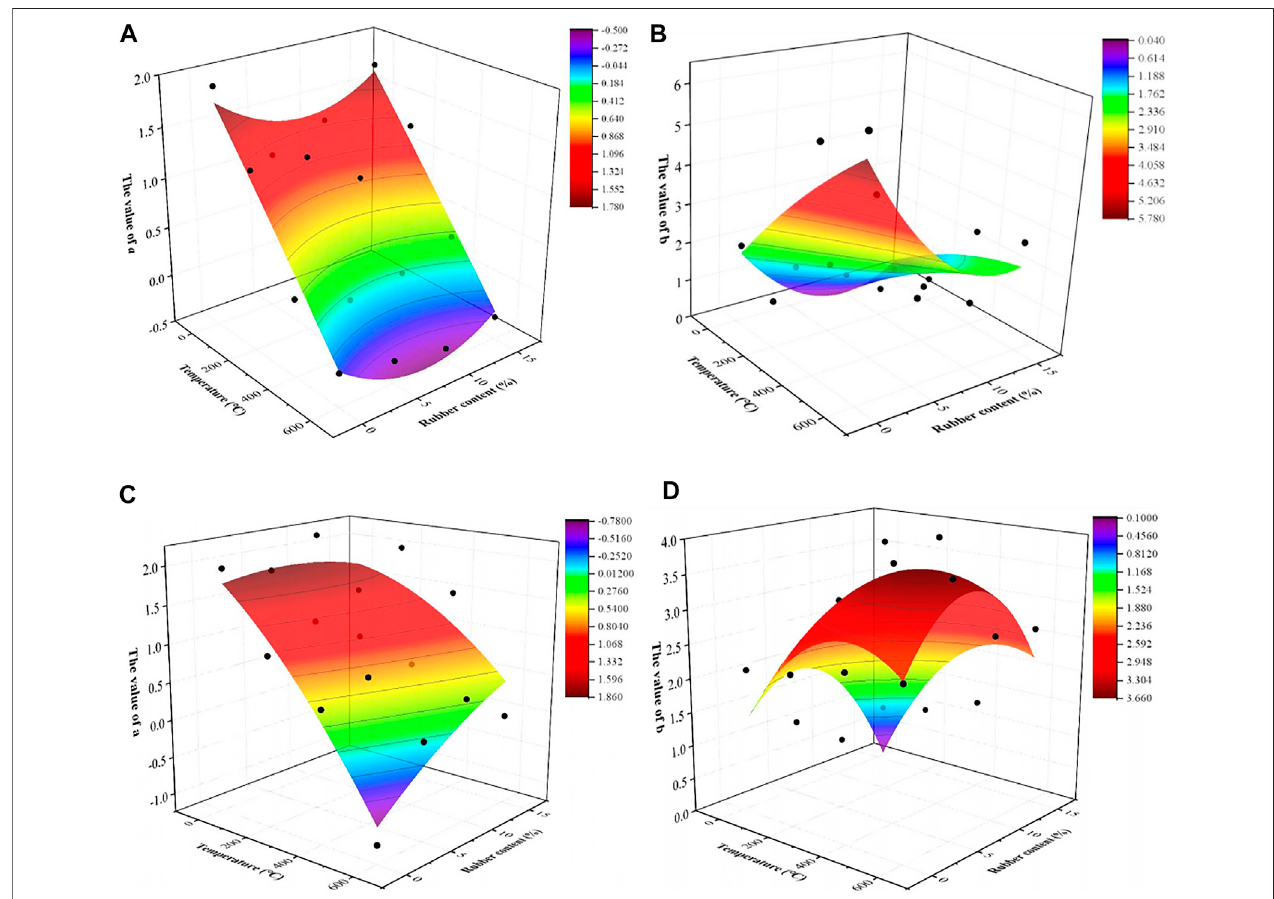
FIGURE 14 | Fitting results of RRAC: (A) a of RRAC-A; (B) b of RRAC-A; (C) a of RRAC-B; (D) b of